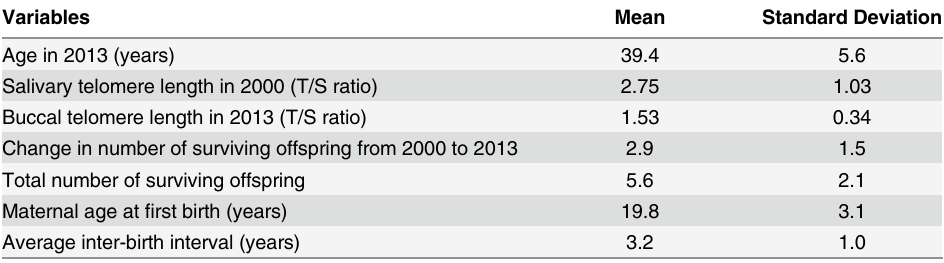
Table 1. Descriptive study population statistics (n =